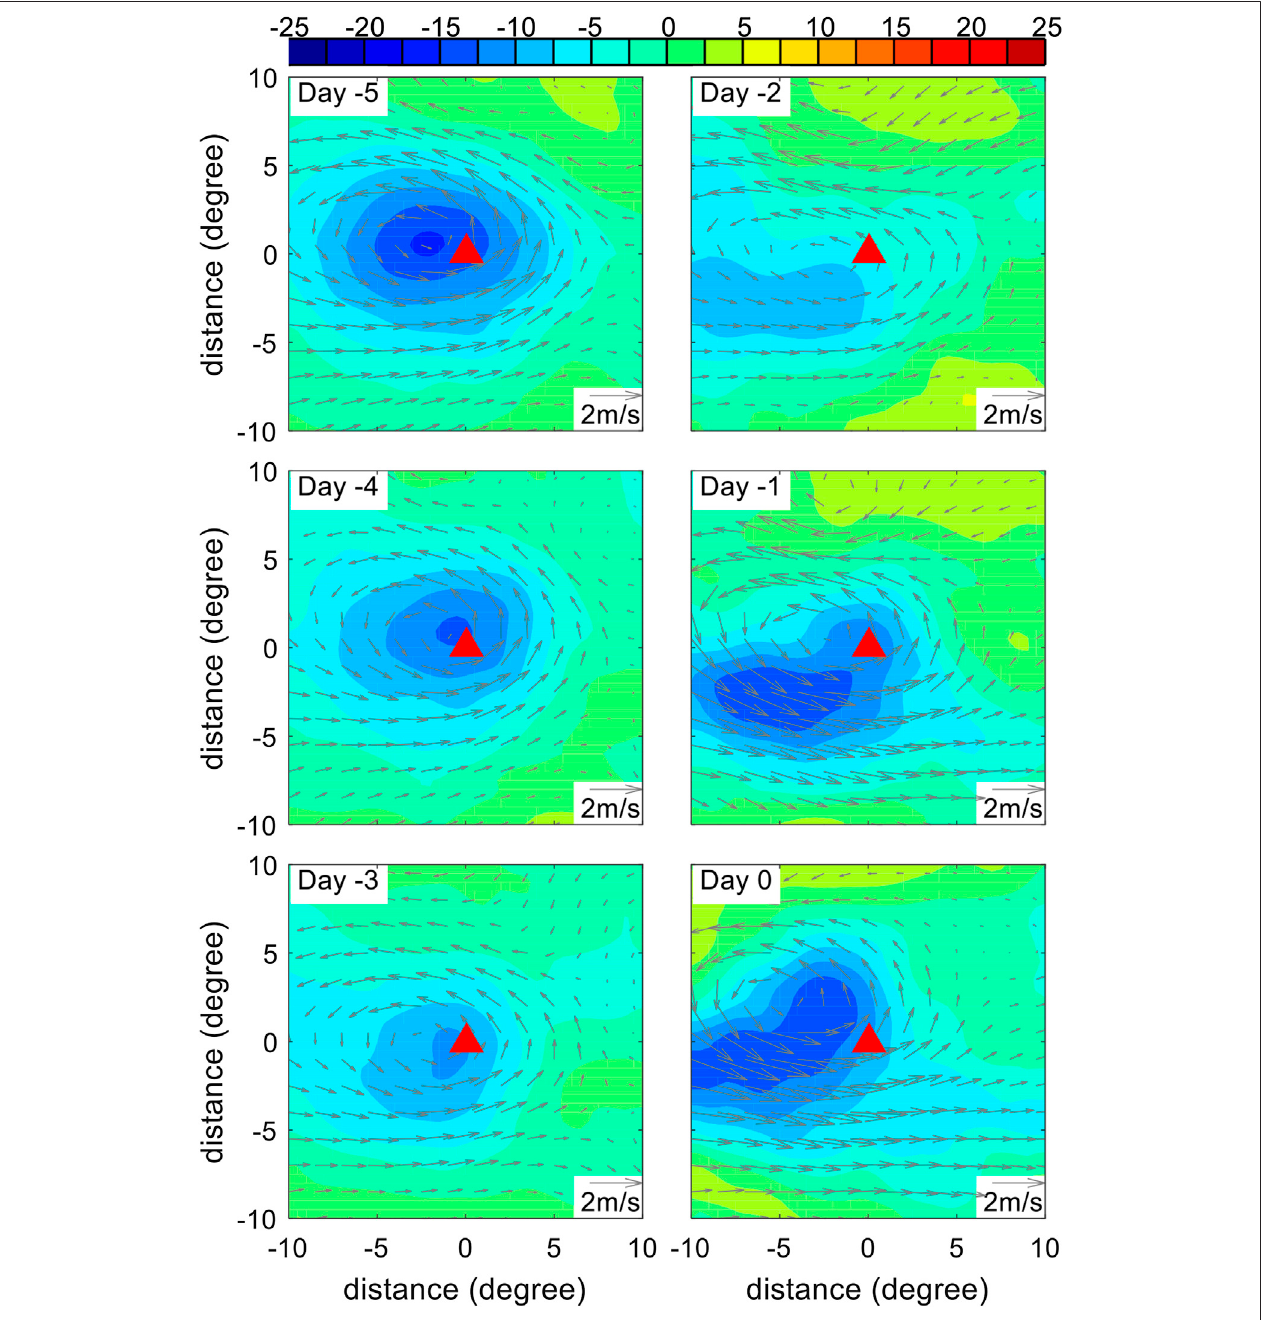
FIGURE 10 | The composite 10 – 20 days fi ltered OLR anomalies (color, W m − 2 ) and 300 – 850 hPa mass-weighted steering fl ow (vectors, m s − 1 ) around the TC centerfornonlocalTCsenteringtheSCSinphase4ofQBWO.ThenumbermeansthedaysbeforethedatethattheTCsenteredtheSCS.Theredtrianglerepresentsthe TC